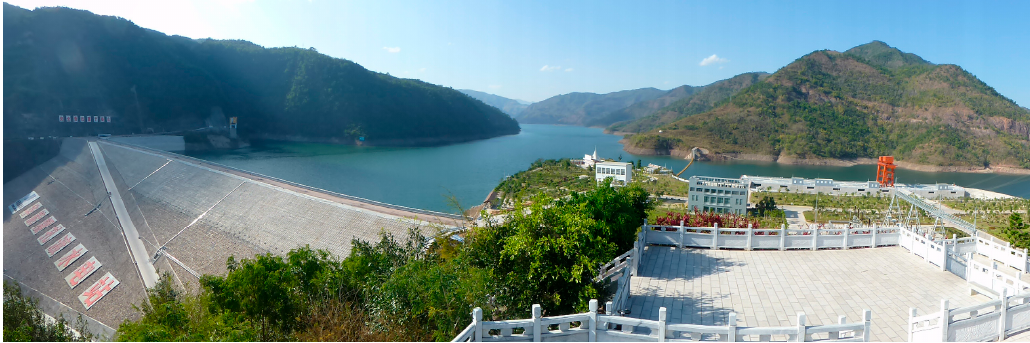
Figure 5. Nuozhadu, the largest hydropower project in terms of installed capacity (5850 MW) and storage reservoir along the Mekong, and one of the key projects for Yunnan’s electricity transfer to Guangdong (Photo: He Daming).